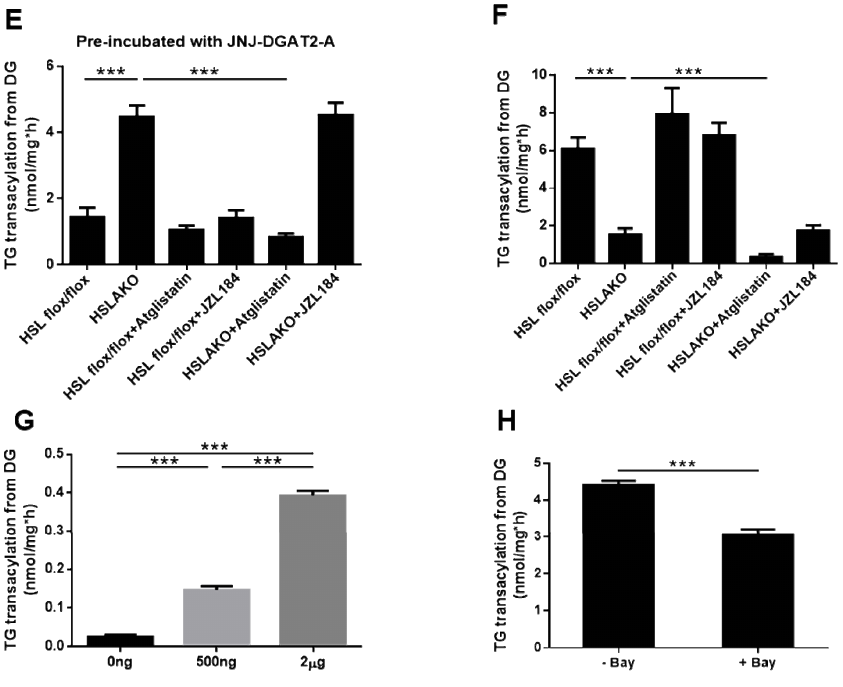
Figure 2. Levels of 3 H-TG transacylation from 3 H-DGs. ( A ) Levels of 3 H-TG transacylation from 3 H-DGs in WAT cytosol from 5-h and 24-h fasted mice. ( B ) Levels of DGAT2 and ER marker Grp78 protein in the isolated lipid droplet (LD) fraction of HSL flox / flox and HSLAKO mice were measured by Western blotting. Positive control means cytosolic protein from HSL flox / flox mice. ( C ) Levels of 3 H-TG transacylation from 3 H-DGs in WAT lipid droplet extracts from 5-h and 24-h fasted mice. ( D ) Levels of 3 H-TG transacylation from 3 H-DGs in WAT lipid droplet extracts from 24-h fasted mice in the presence or absence of ATGL inhibitor and MGL inhibitor. ( E ) Levels of 3 H-TG transacylation from 3 H-DGs in WAT lipid droplet extracts, which were pre-incubated with DGAT2 inhibitor, from 24-h fasted mice in the presence or absence of ATGL inhibitor and MGL inhibitor. ( F ) Levels of 3 H-TG transacylation from 3 H-DGs in WAT lipid droplet extracts from 5-h fasted mice in the presence or absence of ATGL inhibitor and MGL inhibitor. ( G ) Levels of 3 H-TG transacylation from 3 H-DGs in the presence of the indicated amounts of purified HSL protein. ( H ) Levels of 3 H-TG transacylation from 3 H-DGs in WAT lipid droplet extracts in the presence or absence of the HSL inhibitor, Bay. HSLAKO: adipose specific HSL deficient mice. Atglistatin (40 µ M), ATGL inhibitor; Bay (50 nM), HSL inhibitor; JZL184 (1 µ M), MGL inhibitor; JNJ-DGAT2-A (50 µ M), DGAT2 inhibitor. (n = 6 mice under each condition.). Values are mean ± S.E.M. * p < 0.05, ** p < 0.01, *** p <